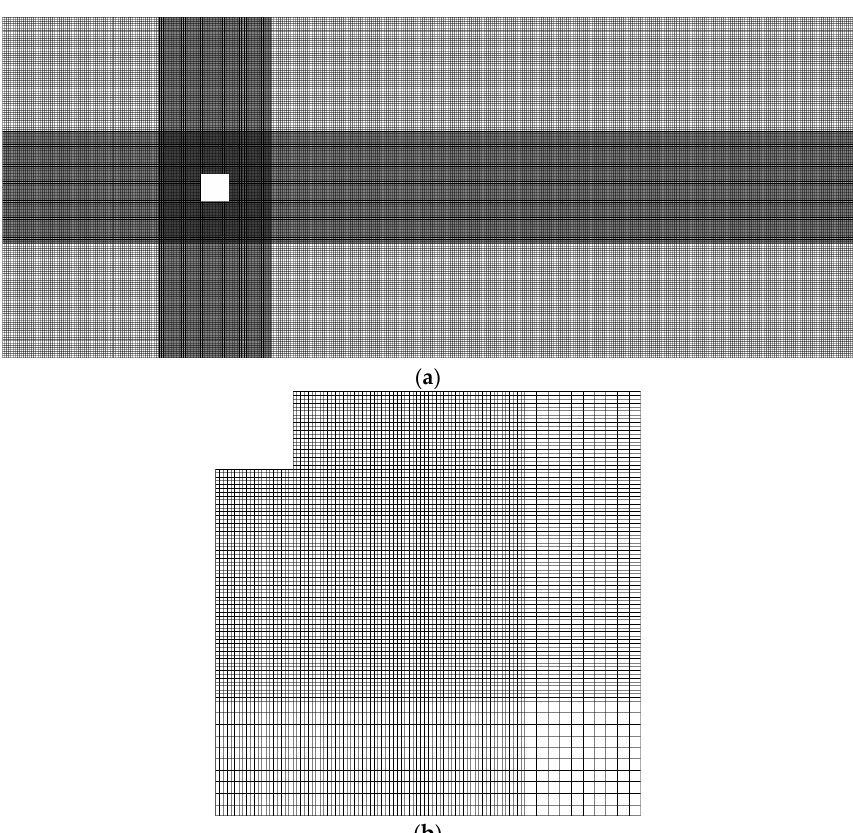
Figure 3. Computational grids distribution of the computational domain; ( a ) total computational grids distribution; ( b ) detailed computational grids distribution close to the square cylinder.